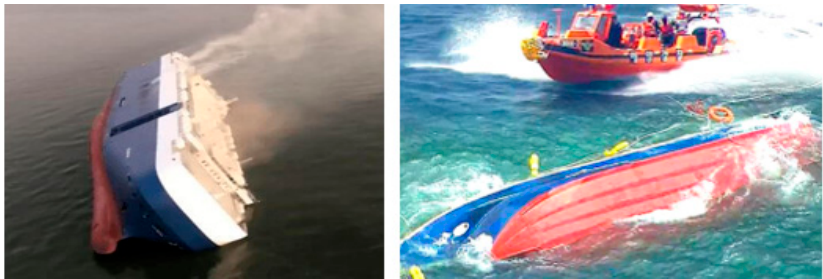
Figure 1. Golden Ray car carrier ( Left ) and Dolgorae fishing vessel ( Right ) accidents.